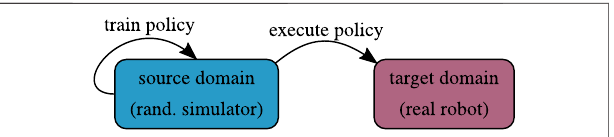
FIGURE 4 | Conceptual illustration of static domain